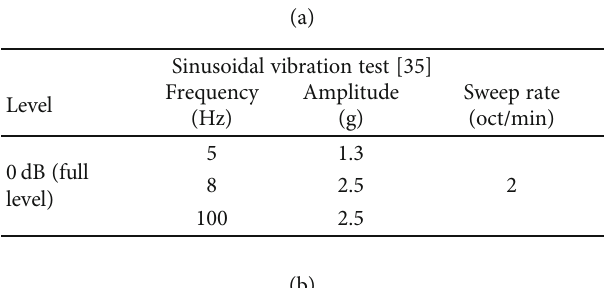
Table 4: Summary of the quali fi cation-level launch vibration test speci fi cations.